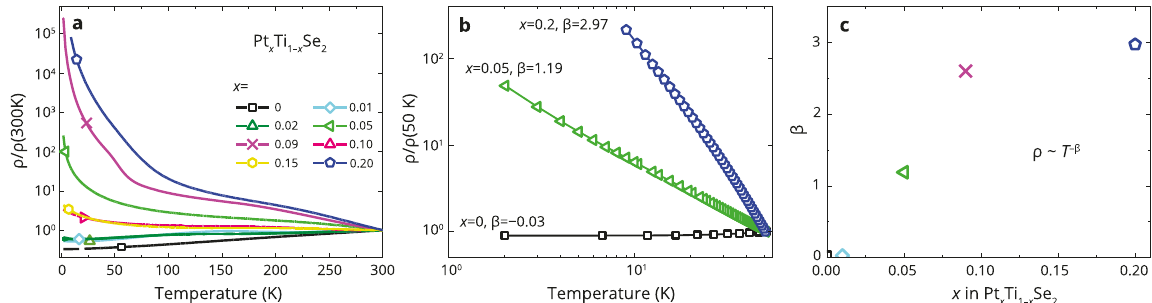
Fig. 2 MIT in 1T-Pt x Ti 1 − x Se 2 from transport measurements. a Resistivity ( ρ / ρ 300K ) as a function of temperature for various Pt doping x . 1T- Pt x Ti 1 − x Se 2 initially shows metallic behavior but quickly becomes insulating with increasing x . b Log-log plot of resistivity vs. temperature for single crystal data at temperatures below 50 K. c Power β (in ρ ~ T − β ) vs. doping x , for single crystal measurements for the insulating of the defects observed in topography images from scanning tunneling microscopy (shown in Supplementary Fig. 7), and reaf fi rms the experimental fi nding on polycrystalline samples 12 .